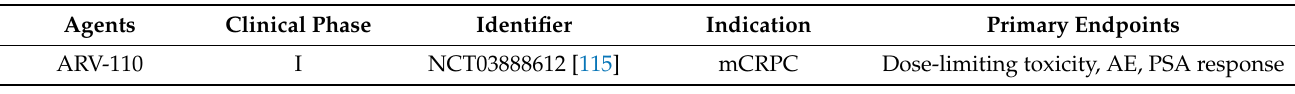
Table 3. Clinical trials evaluating AR degradation therapy for the treatment of PCa. Agents Clinical